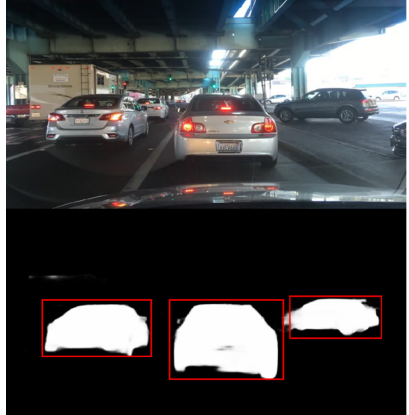
Figure 7. There are three salient objects in the traffic scene. Their confidences judged to be the cars from left to right are 0.929, 0.903,